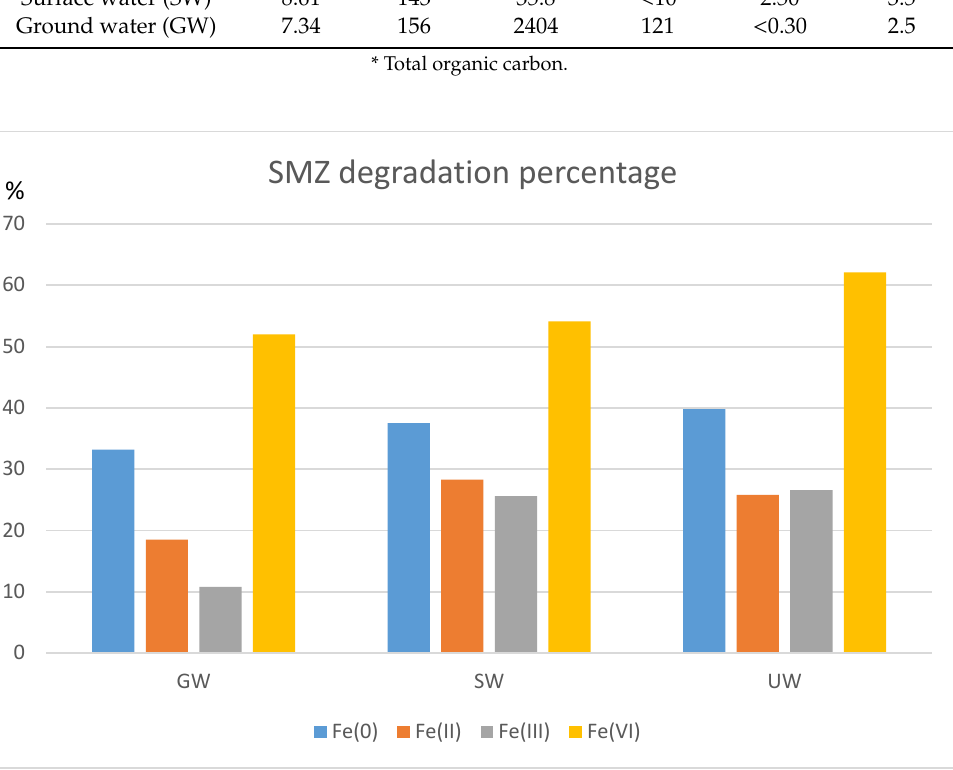
Figure 4. Degradation percentage of SMZ by iron-based/sulfite systems in different water matrixes. [SMZ] = 5.38 × 10 −5 M, [Fe(0–VI)] = 1.79 × 10 −2 M, [sulfite] = 5.0 × 10 −3 M, T = 298 K.